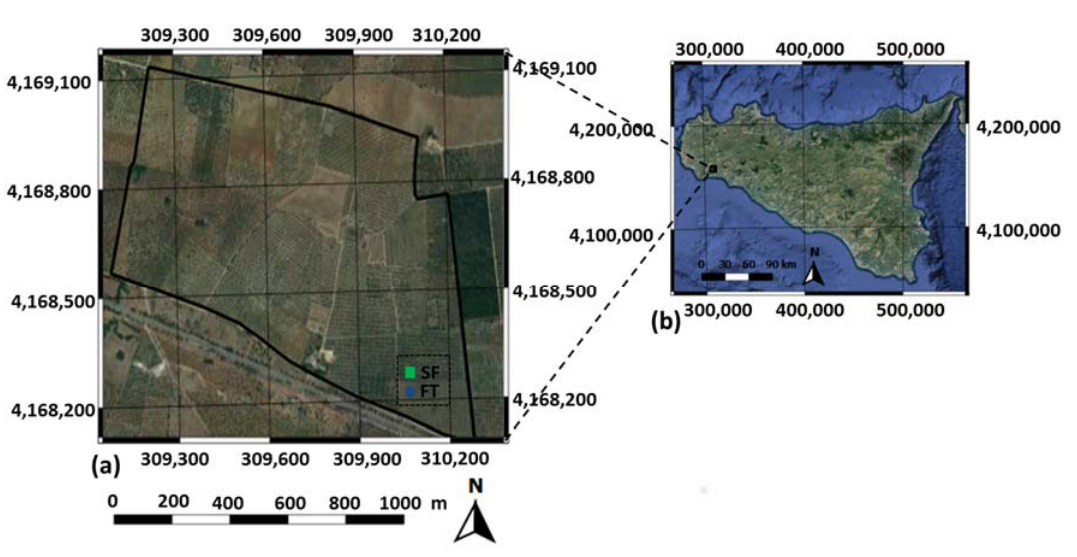
Figure 1. ( a ) Geographical location of the experimental fields; the continuous black boundary has average coordinates of lat.: 37.6424°; long: 12.8464°; UTM WGS 84, which is close to the town of Castelvetrano, in the island of ( b ) Sicily, Italy. The blue dot and green square indicate the positions of FT and the average position of SF stations, respectively.